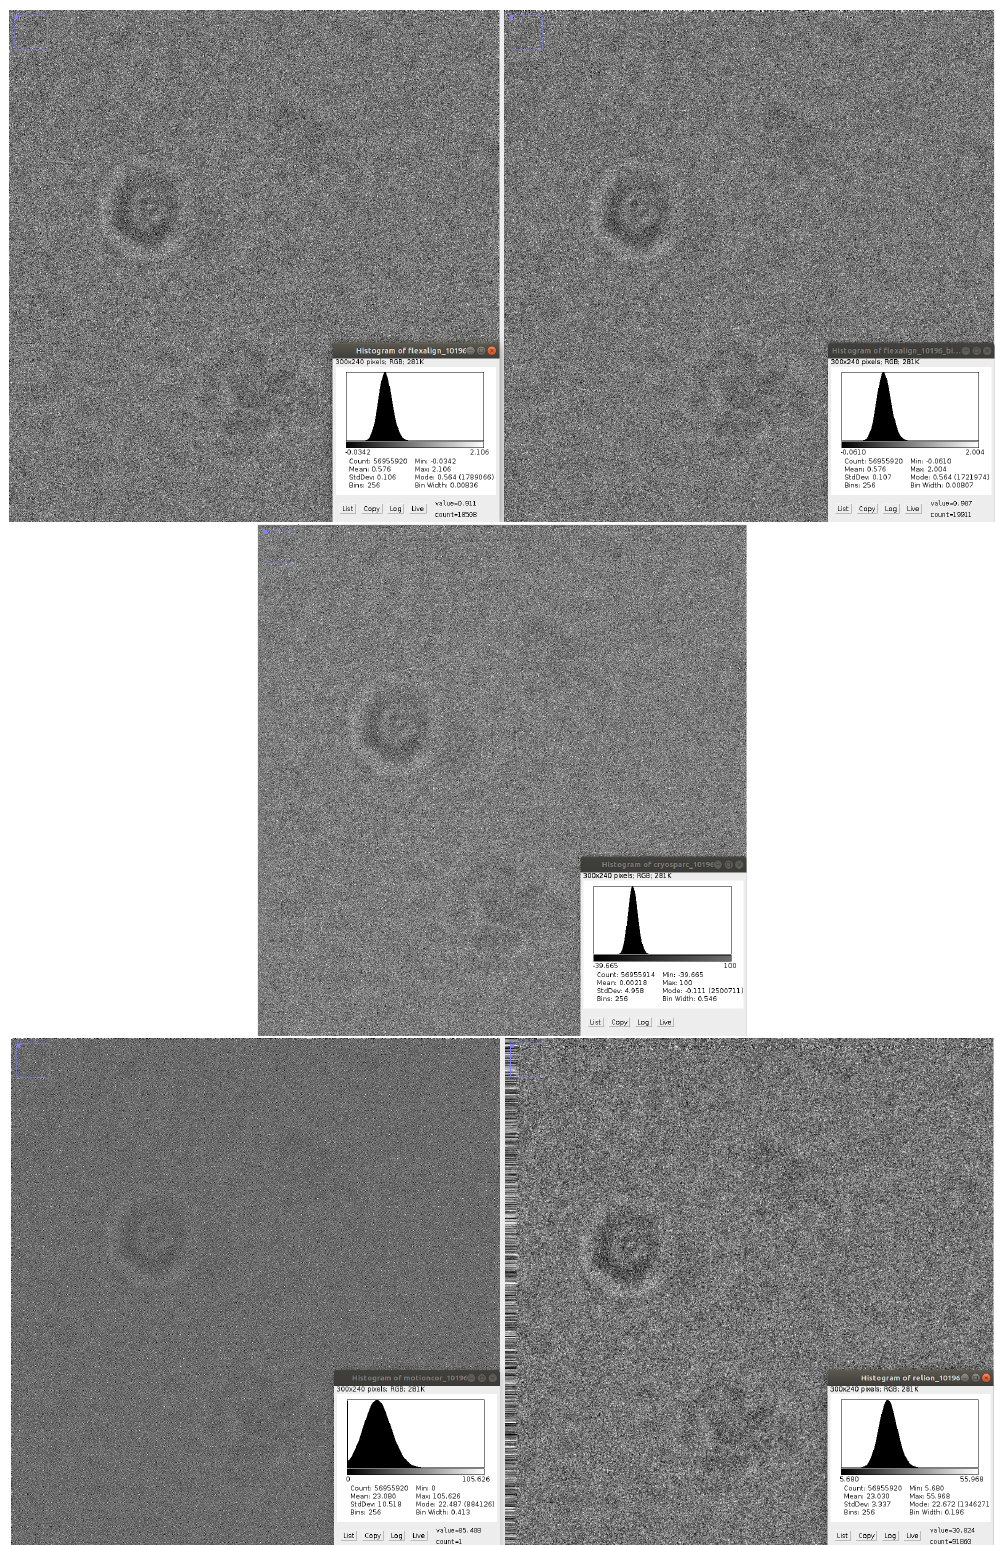
Figure 15. Details of the produced micrograph using EMPIAR 10196 dataset (normalized) with histogram (before normalization): FlexAlign ( top left ), FlexAlign with max shift of 80 px ( top right ), cryoSPARC ( center ), MotionCor2 ( bottom left ), Relion MotionCor ( bottom right